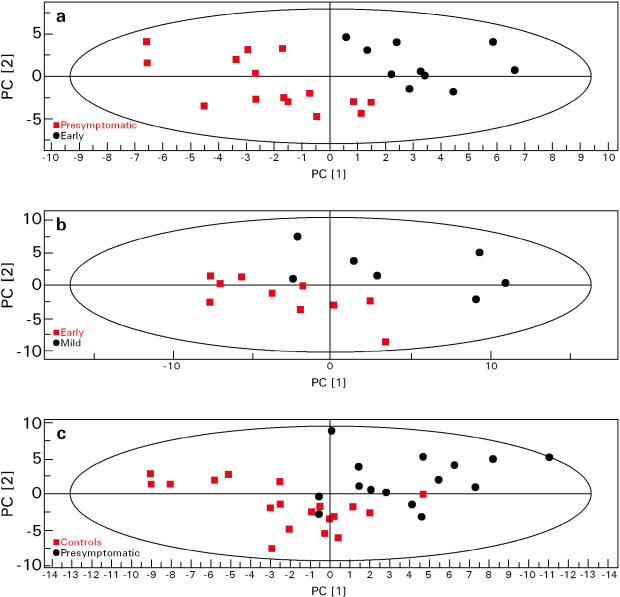
Partial least square (PLS) analyses of NMR spectra of plasma samples from HD patients with no or little signs of the disease and controls.Three groups of presymptomatic, early and mildly affected HD patients were constituted on the basis of their UHDRS scores, as described in the methods. The first and second components in the X space (NMR spectrum) are denoted PC[1] and PC[2] respectively. PLS score plots (PC[1]/PC[2]) of pair-wise compared groups show the greater variation within the NMR spectrum according to a priori classification with UHDRS. There is a clear separation between presymptomatic and early HD patients (a), as well as between early and mildly affected HD patients (b). Despite some overlap, presymptomatic mutation carriers can also be distinguished from controls (c).